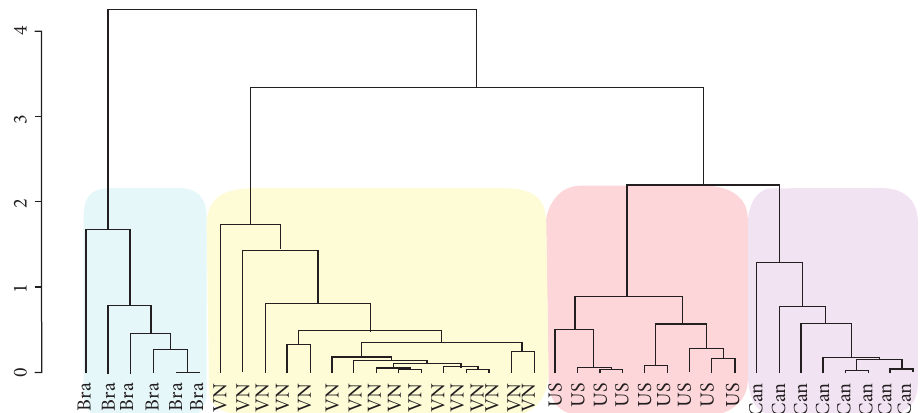
Figure 1: HCA dendrogram of soybean samples.